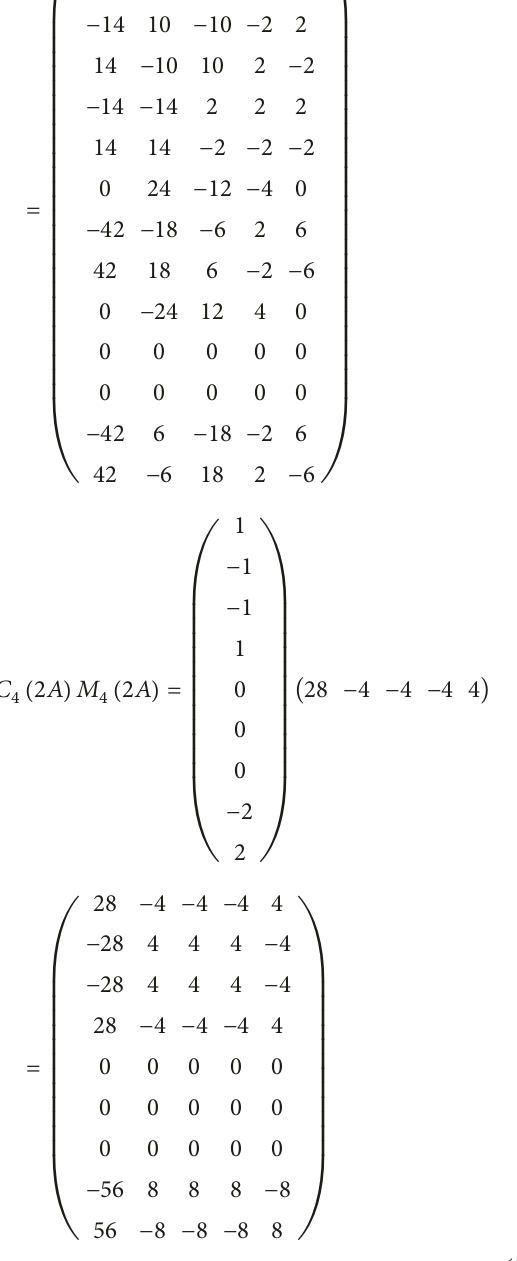
Table 5: The fusion of 𝐻 4 into 𝐿 3 (4) : 2 .